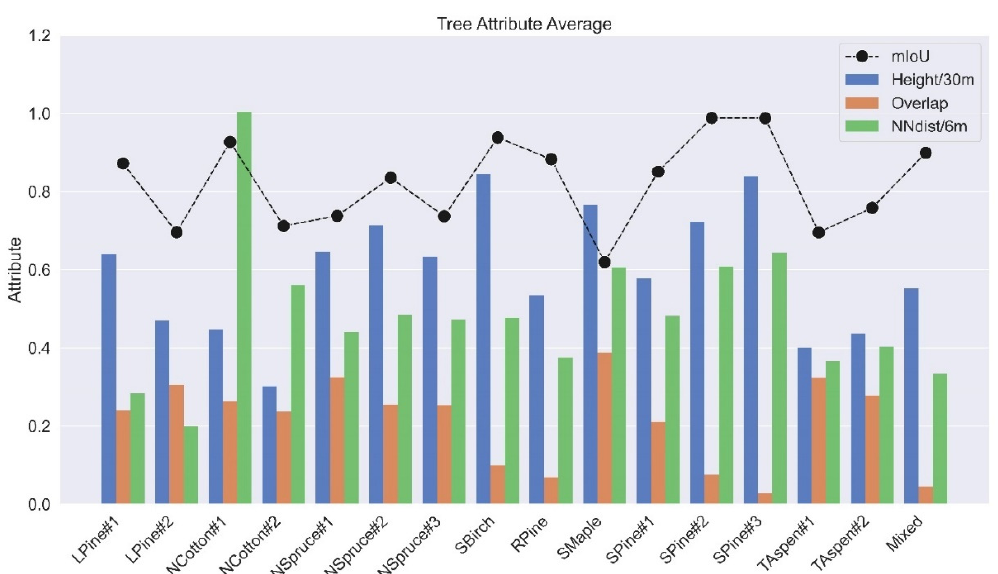
Figure 11. Tree attributes averaged over each plot. Height is divided by 30 m and NNdist divided by 6 m to reduce the bar height difference from Overlap for better visualization.